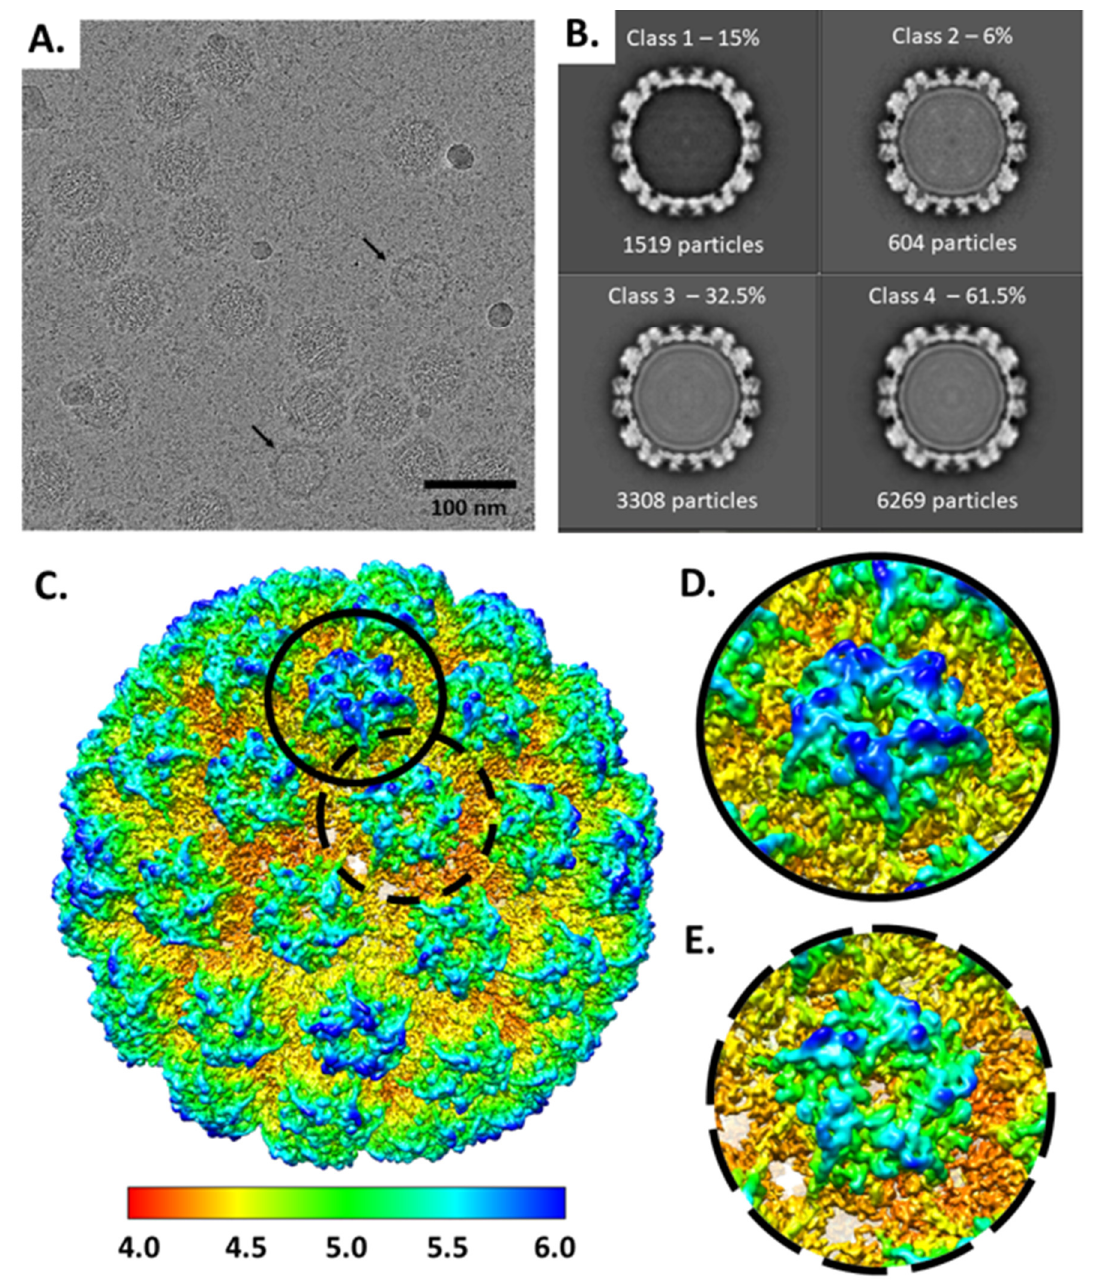
Figure 1. Cryo EM Icosahedral Reconstruction. ( A ) Representative micrograph 386/2,859 at 14,475 Å defocus with a slight grainy background possibly due to residue from the purification gradient (Methods). Some particles are devoid of genome (black arrows). ( B ) Three-dimensional classification sorted into 4 classes. Class 1 accounts for 15% of the particles and has a bright white capsid density shell, with a dark core corresponding to lack of internal density. Due to the low particle number, a separate reconstruction of empty capsids was not pursued in this study. Classes 2–4 that have gray internal density denoting a packaged genome were selected and used for all further processing. ( C ) Local resolution of the icosa- hedral reconstruction displayed surface rendered. Red represents highest resolution values (4.0 Å) and dark blue repre- sents lowest resolution values (6.0 Å). The pentavalent capsomer (solid black line) and the hexavalent capsomer (dotted black line) are shown as zoomed views ( D , E ). 3.2. There Are Resolution Differences between Hexavalent and Pentavalent Capsomers Local resolution of the icosahedrally refined virus capsid showed capsomers in the hexavalent environment had better resolution than the pentavalent capsomers. The cen- tral density of all capsomers, comprised of β -strands, was uniform between the two